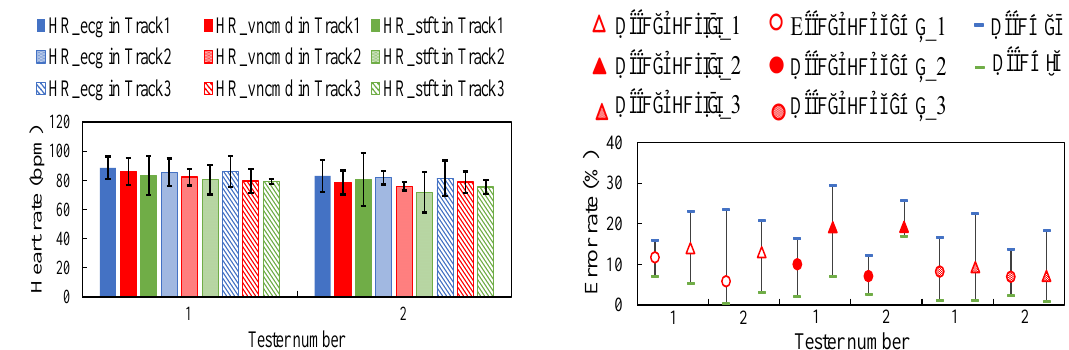
Figure 11. Results on moving testers in Track 1.